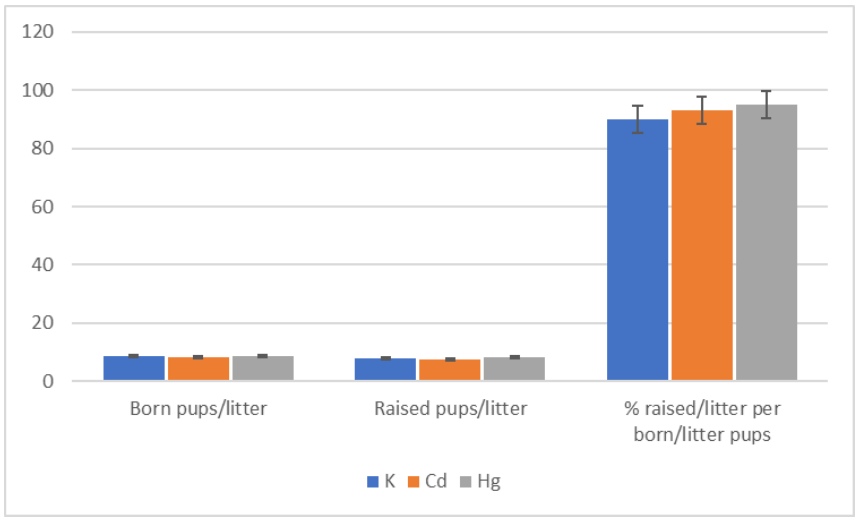
Figure 6. A comparison of average number of pups born and raised per litter during the experiment and the percentage of pups raised/litter out of the born/litter. n = 8 per